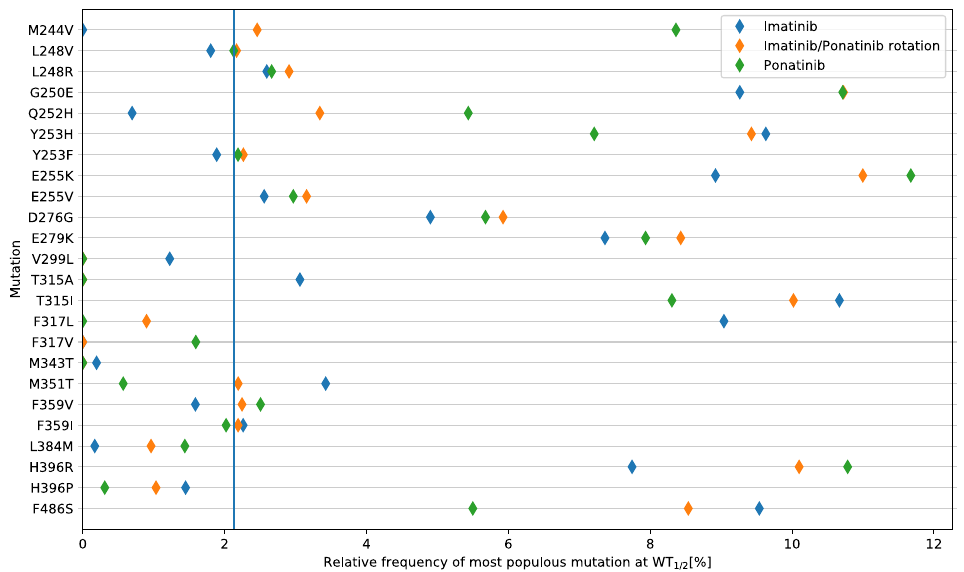
Figure 4. Calculated frequencies of the mutations when half of the population of cancer stem cells is no longer wild-type. Calculations were performed for cells treated with imatinib, ponatinib, or a rotation of the